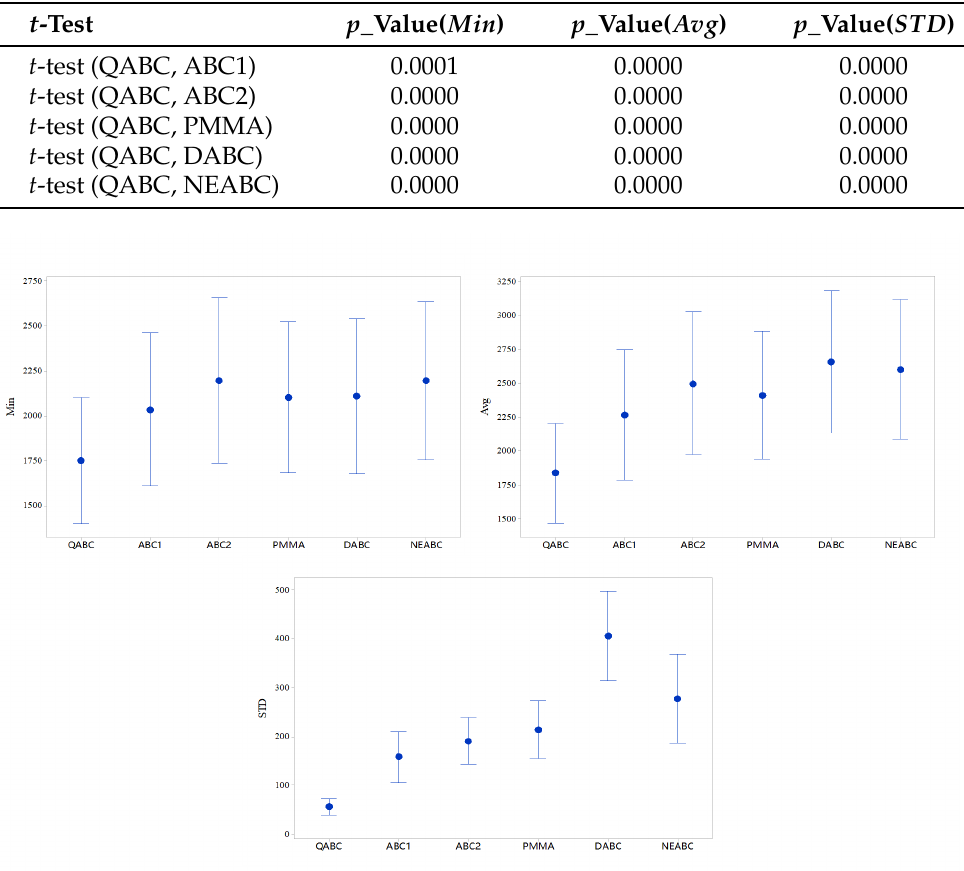
Figure 11. Mean plot with 95% confidence interval for all algorithms.